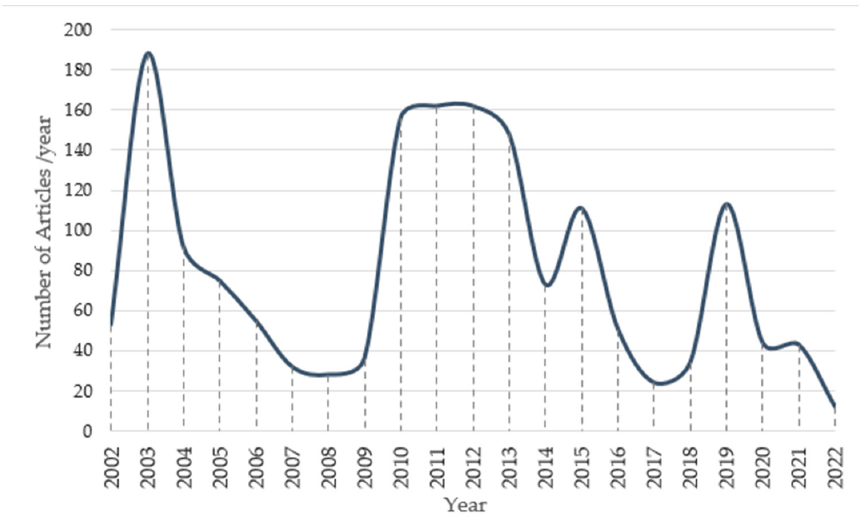
Figure 2. Annual production of the ‘strategic opportunity period’ narrative in Chinese academia (2002–2022).